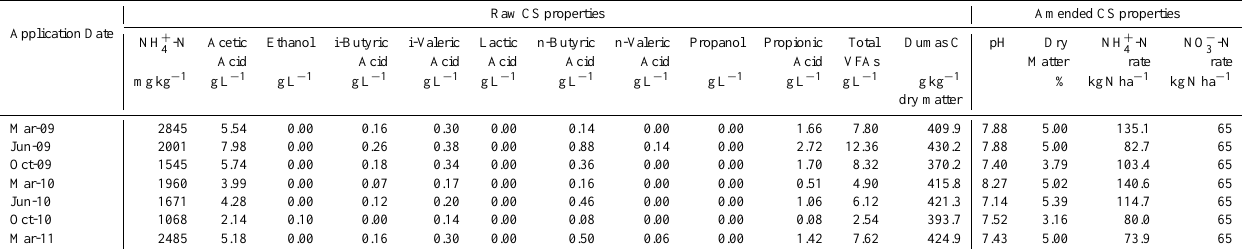
Table 1. Properties and application rates of the cattle